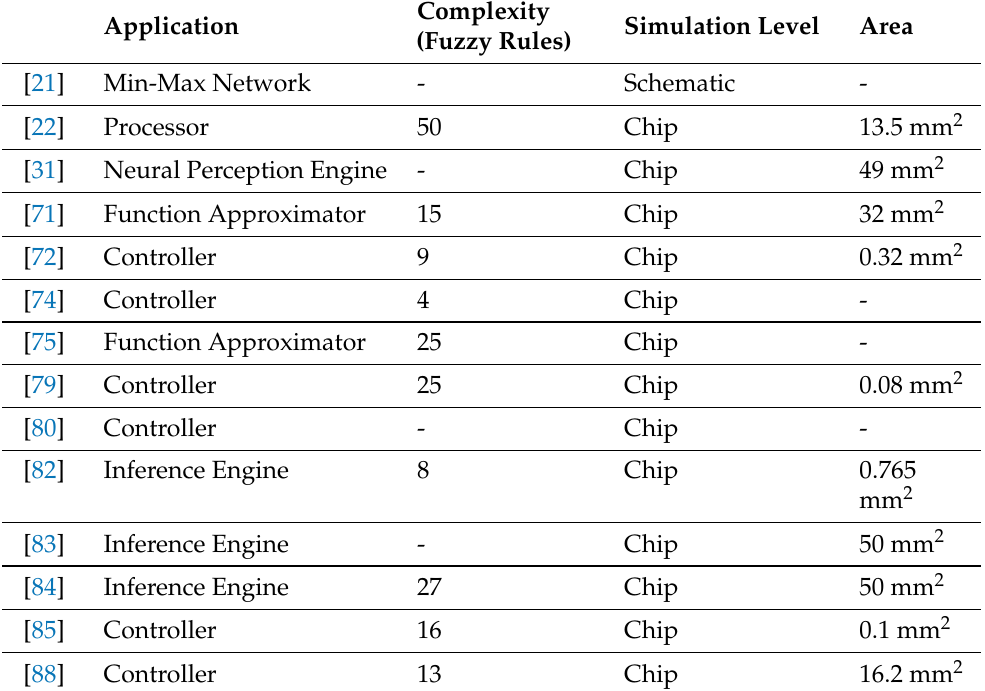
Table 10. Neuro-fuzzy Systems